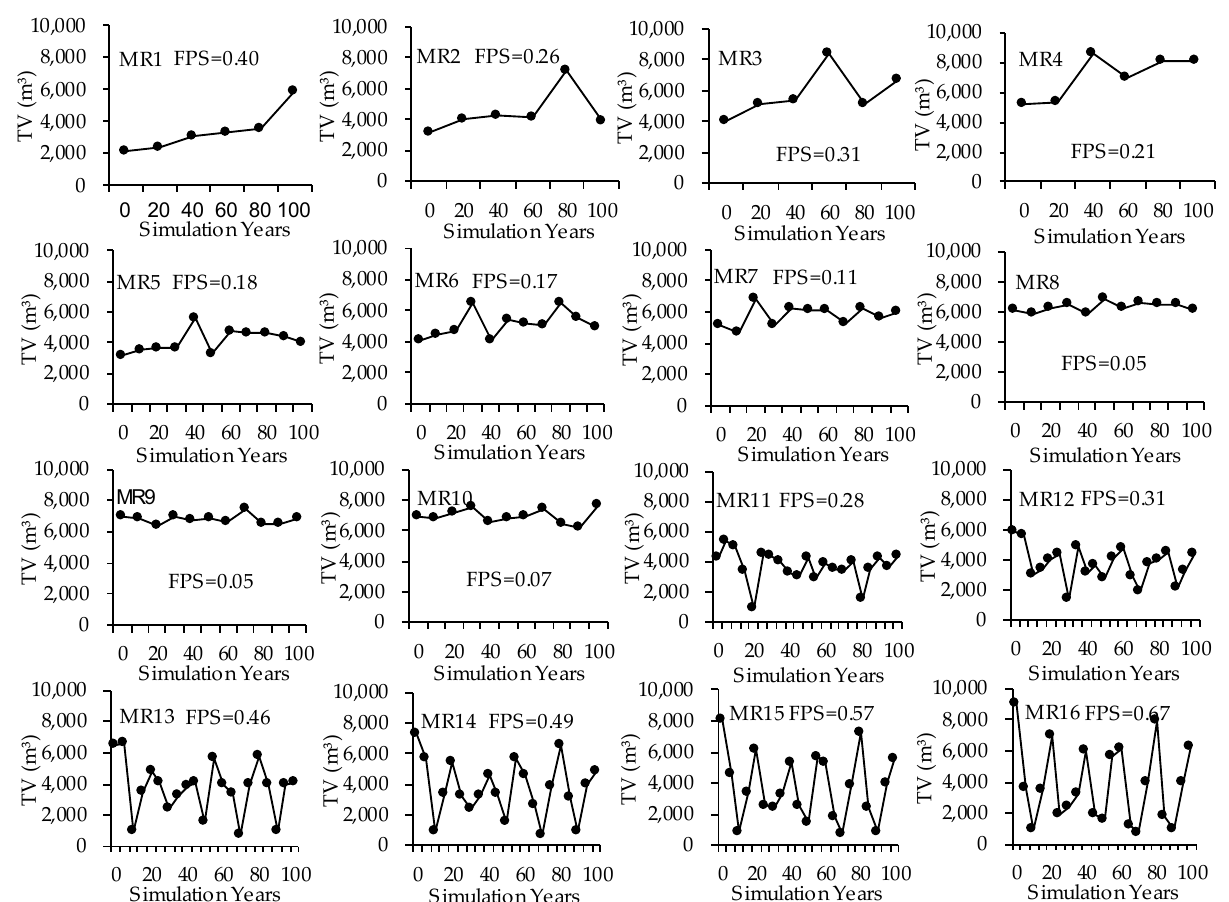
Forests 2021 , 12 , x FOR PEER REVIEW Figure 3. Fluctuation curve of timber harvest volume over time and FPS in sixteen MRs (TV = timber harvest volume).